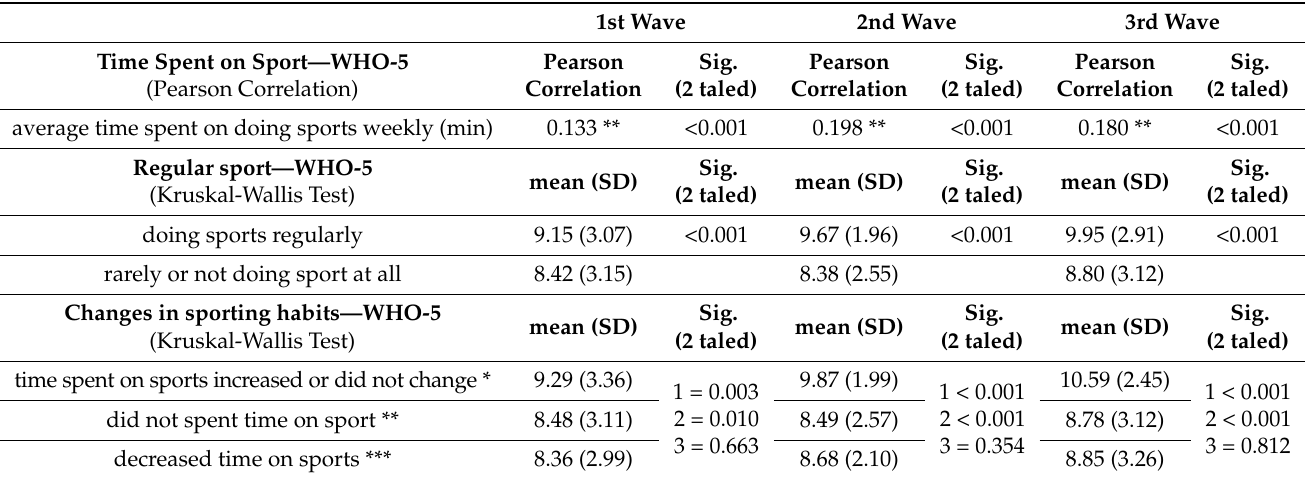
Table 5. Correlations of subjective psychological well-being and time spent doing